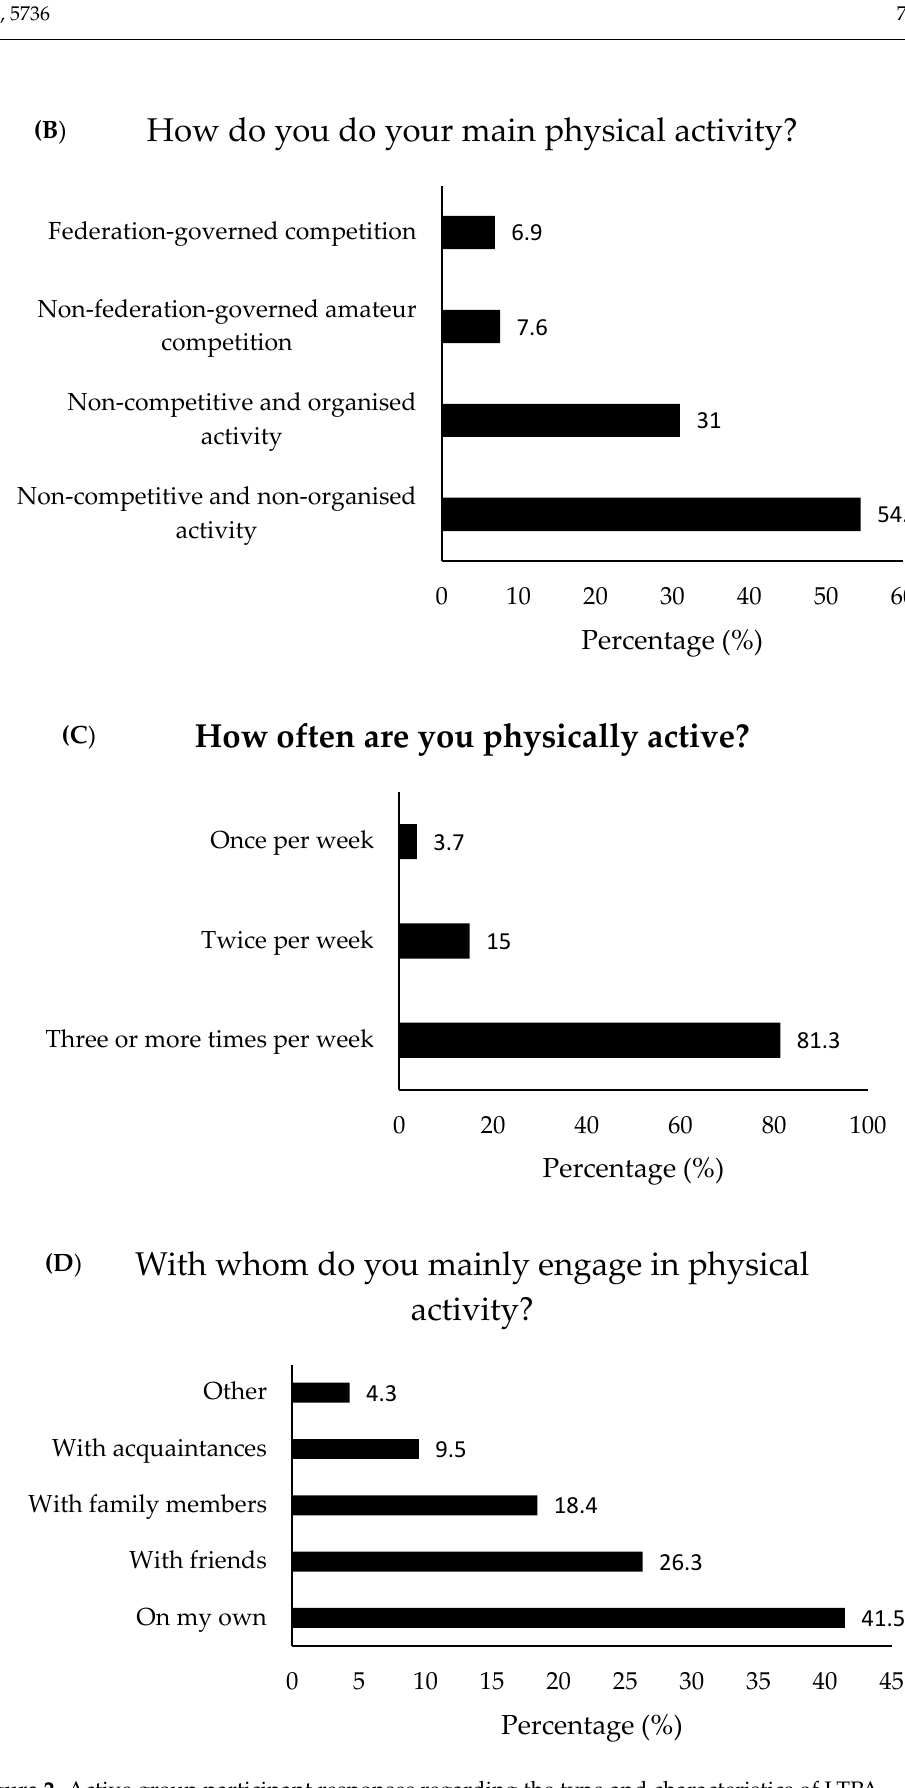
Figure 2. Active group participant responses regarding the type and characteristics of LTPA. Barriers to LTPA participation and intention to change (inactive group): The results con- cerning the main barriers to being physically inactive in LTPA among inactive women (<150 min/week, 32% of the total, n = 1137 women) are shown in Table 3.